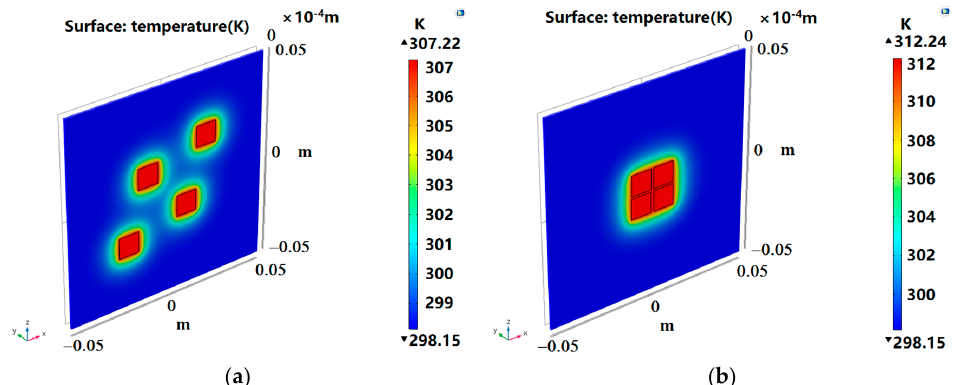
Figure 5. Situation 1: initial layout ( a ) and optimized layout ( b ).